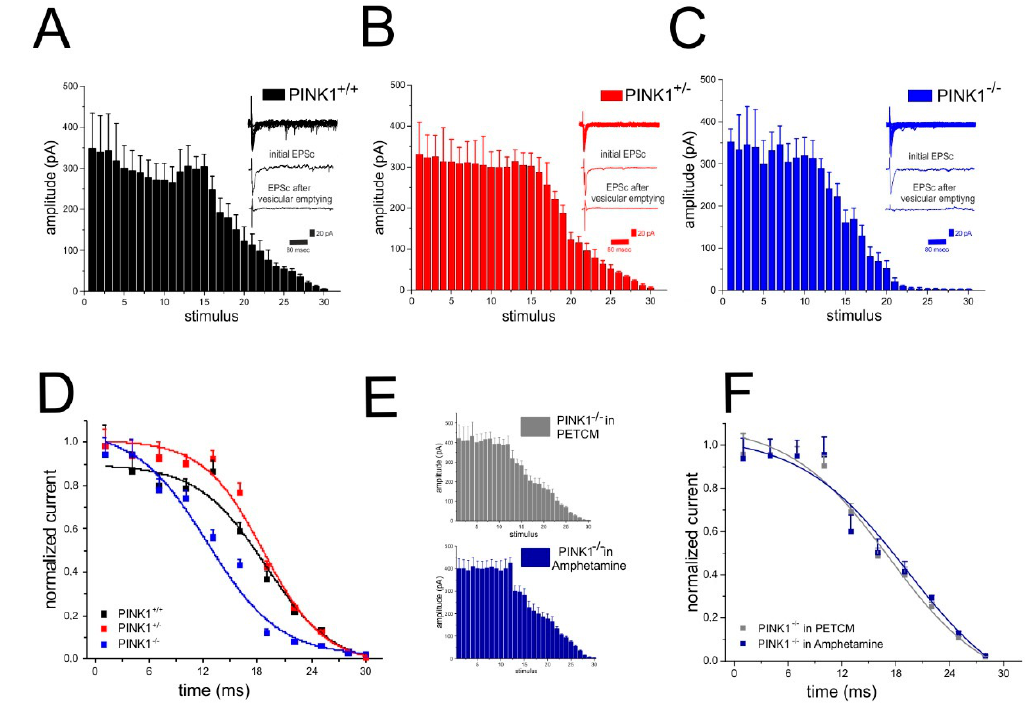
Figure 6. E ff ect of caspase-3 activation on synaptic responses to sustained electrical stimulation in PINK1 − / − MSNs. ( A ) Time-course of synaptic responses to sustained stimulation (30 Hz, 30 s) in PINK1 +/+ MSNs. Current peak amplitudes are reported as mean ± SEM. In the inset, the first and last EPSC from a representative experiment are shown. ( B ) Time course of synaptic responses in PINK1 +/ − MSNs shows a similar response to sustained stimulation. ( C ) In PINK − / − MSNs, we observed a faster depression kinetics after the 12th stimulus. ( D ) In PINK1 +/+ MSNs, the normalized current curve shows an initial fast depression, followed by a slow fall of response. The fit was used to measure the time constant of synaptic depression, which appeared slightly di ff erent in PINK1 − / − mice compared with PINK1 +/+ and PINK1 +/ − mice. Decay time constants: PINK1 +/+ : 18.88 ± 0.8 ms, n = 4; PINK1 +/ − : 18.68 ± 0.56 ms, n = 5; PINK1 − / − : 12,43 ± 2.43 ms, n = 6; ANOVA and Tukey post hoc, p < 0.05). ( E ) Time-course of synaptic responses to sustained stimulation in the presence of amphetamine (100 µ M) (blue) and PETCM (30 µ M) (gray). No significant di ff erences were observed among the three genotypes when PINK1 − / − was treated by either amphetamine. ( F ) No di ff erences were detected between normalized curves obtained from PINK1 − / − MSNs treated with either amphetamine or PETCM. Time constants: PINK1 − / − plus amphetamine: 19.28 ± 0.93 ms, n = 6; p > 0.05 vs. PINK1 − / − ; PINK1 − / − plus PETCM: 17.22 ± 0.86 ms, n = 4; p > 0.05 vs. PINK1 − / −